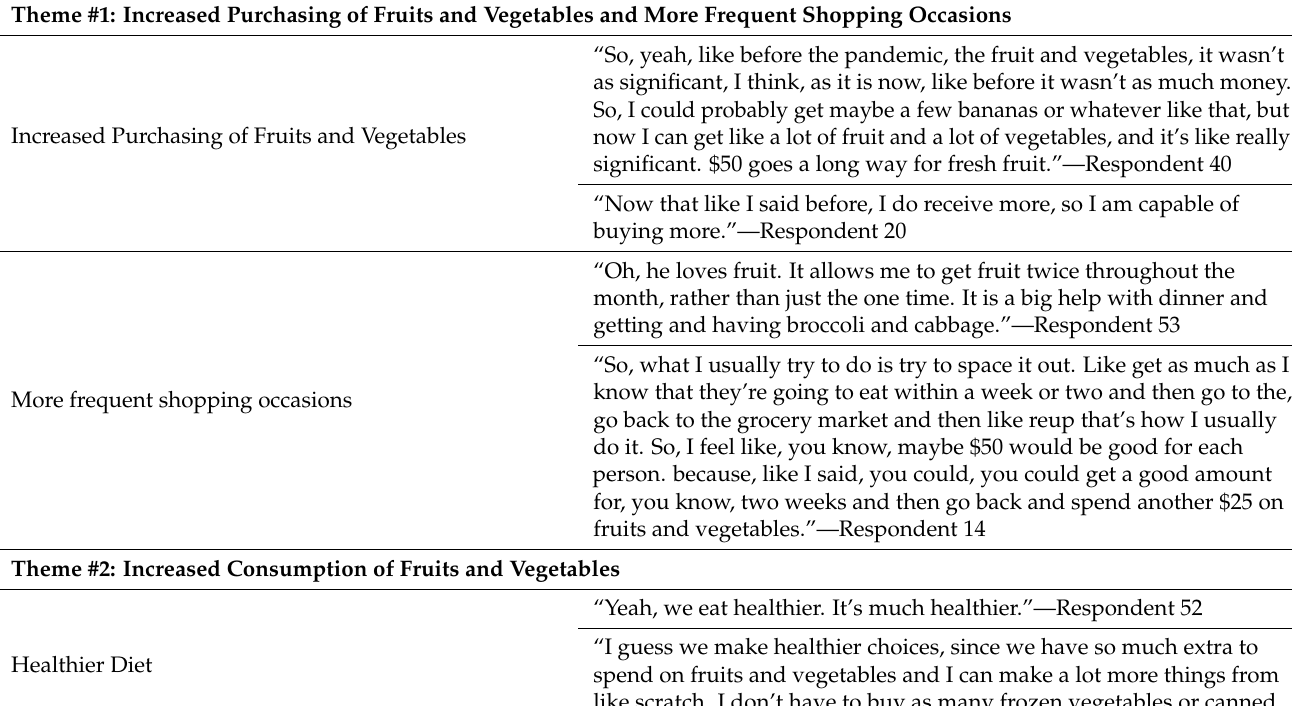
Table 3. Qualitative Themes and Exemplar